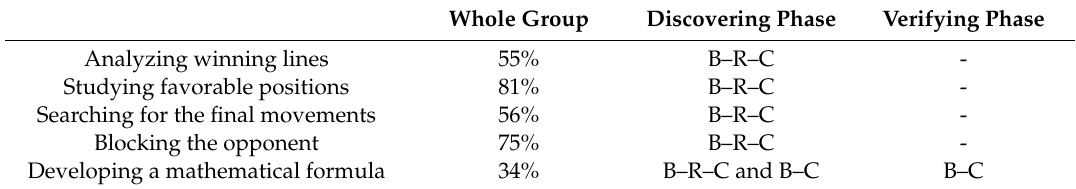
Table 3. Pattern of reasoning sequences in the whole group according to the phases. C: constructing.